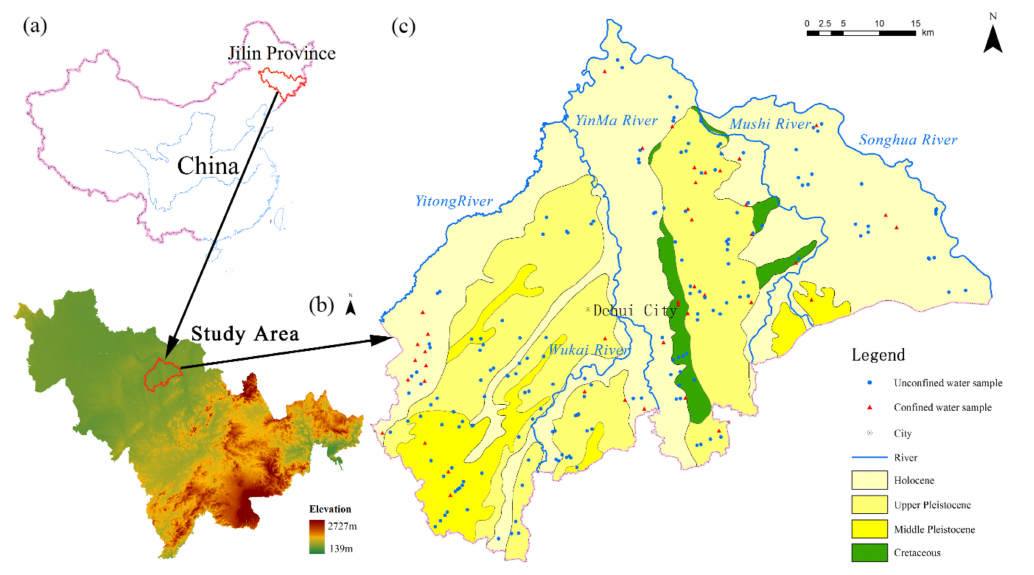
Figure 1. Location of the study area. ( a ) Jilin Province in China, ( b ) the terrain of Jilin Province and the study area in Jilin Province, ( c ) geological map of the study area and location of sampling